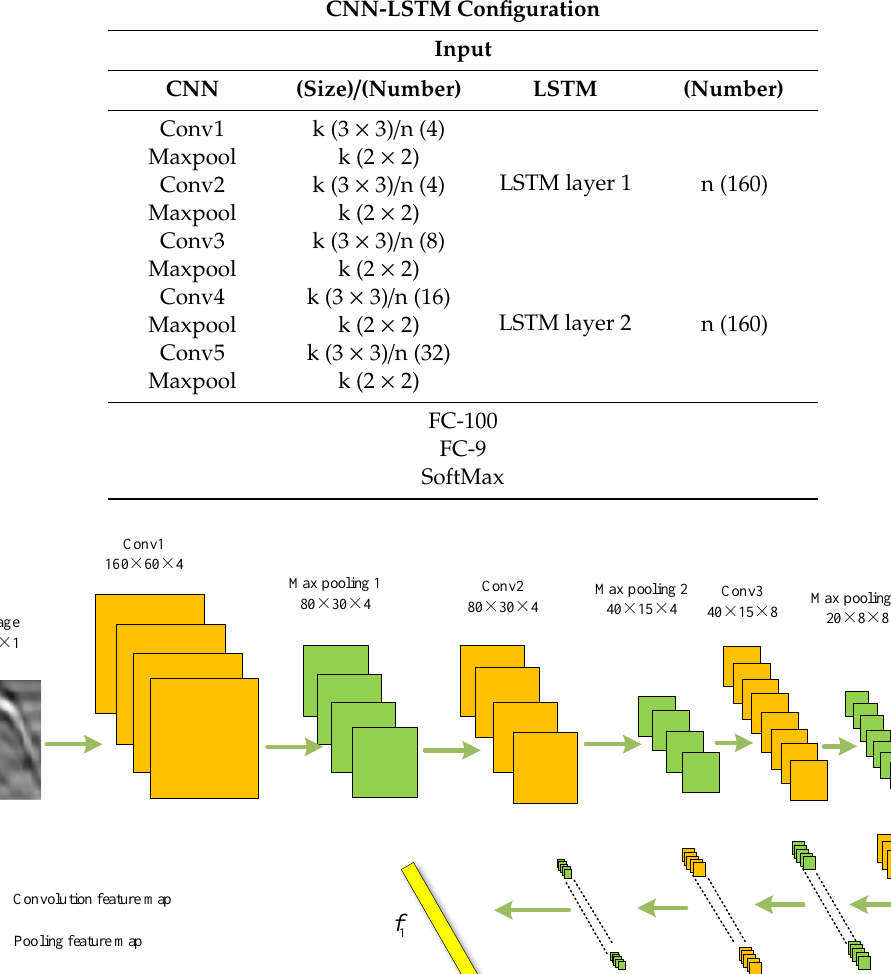
Table 1. CNN-LSTM network configuration.